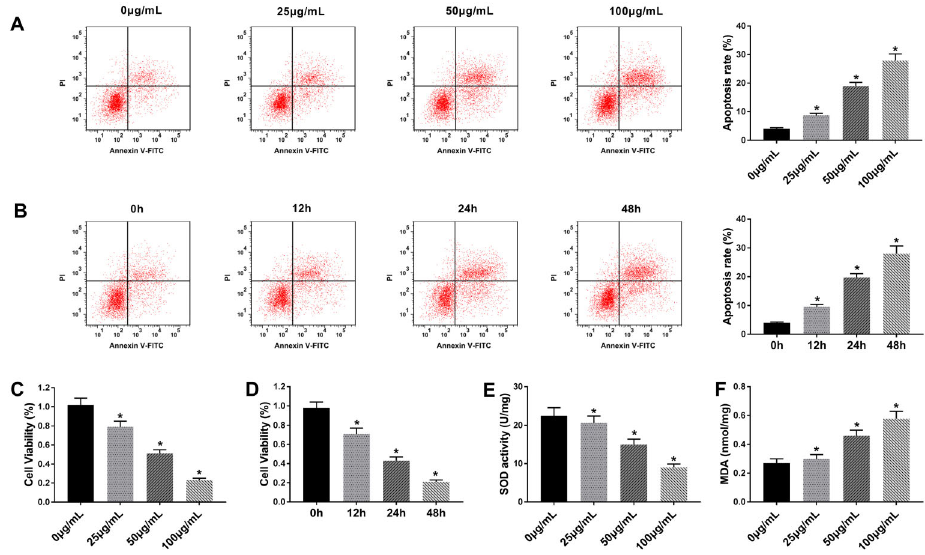
Figure 1. Oxidized low-density lipoprotein (ox-LDL) induced apoptosis and oxidative stress in human umbilical vein endothelial cells (HUVECs). A and B , Apoptosis rate was assessed by fl ow cytometry assay after treatment with ox-LDL (0, 25, 50, and 100 m g/mL for 48 h or 50 m g/mL of ox-LDL for 0, 12, 24, and 48 h). C and D , MTTassay was performed to measure the cell viability of HUVECs treated with ox-LDL. E and F , Superoxide dismutase (SOD) activity and malondialdehyde (MDA) concentration in cell lysates were analyzed. Data are reported as means ± SD with three replicates. *P o 0.05 compared to control